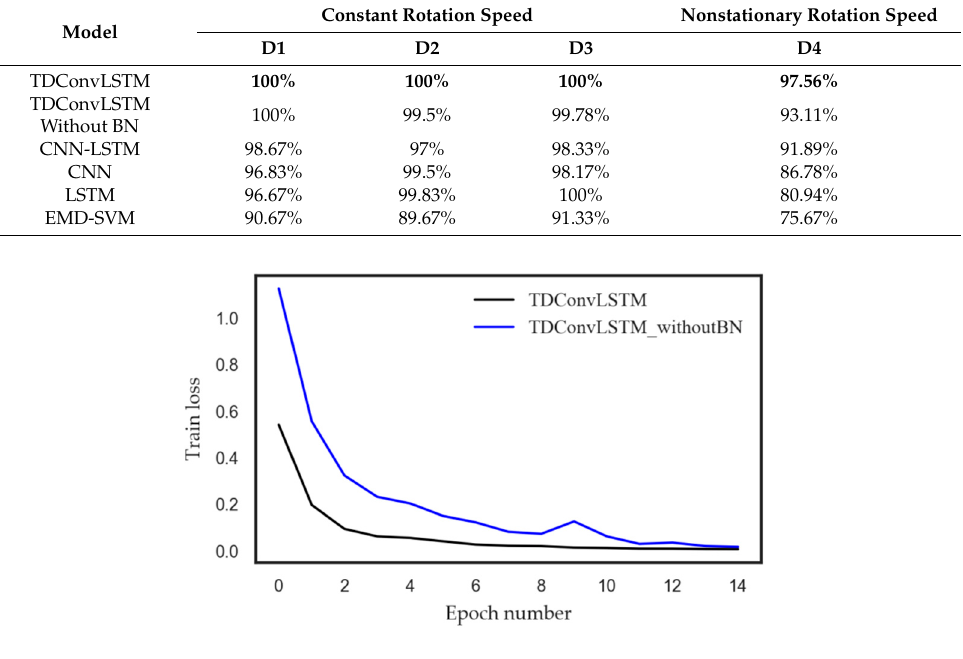
Figure 7. The effect of batch normalization (BN) on model training.